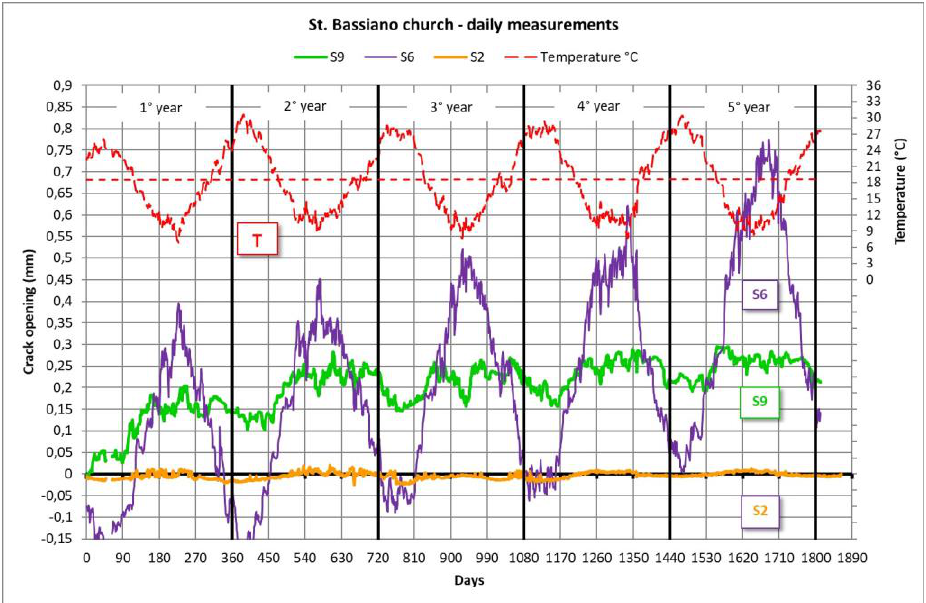
Figure 14. St. Bassiano church: plot of the 5-year crack monitoring, after the strengthening intervention on the nave vaults, apse and roof. Only some significant sensors are plotted.